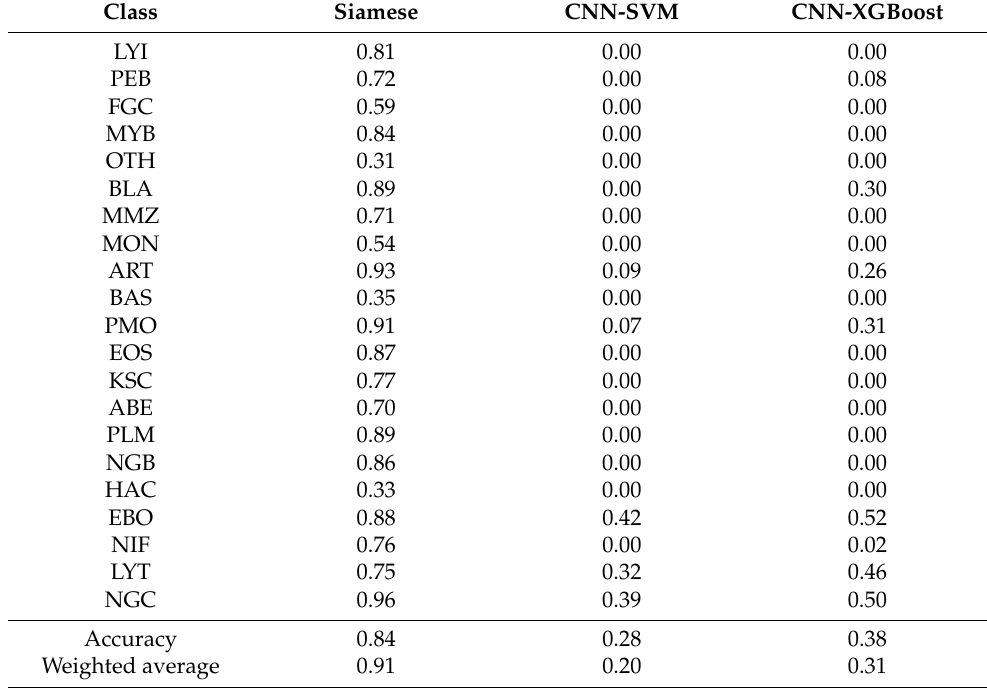
Table 5. Comparison of different approaches used in this study based on